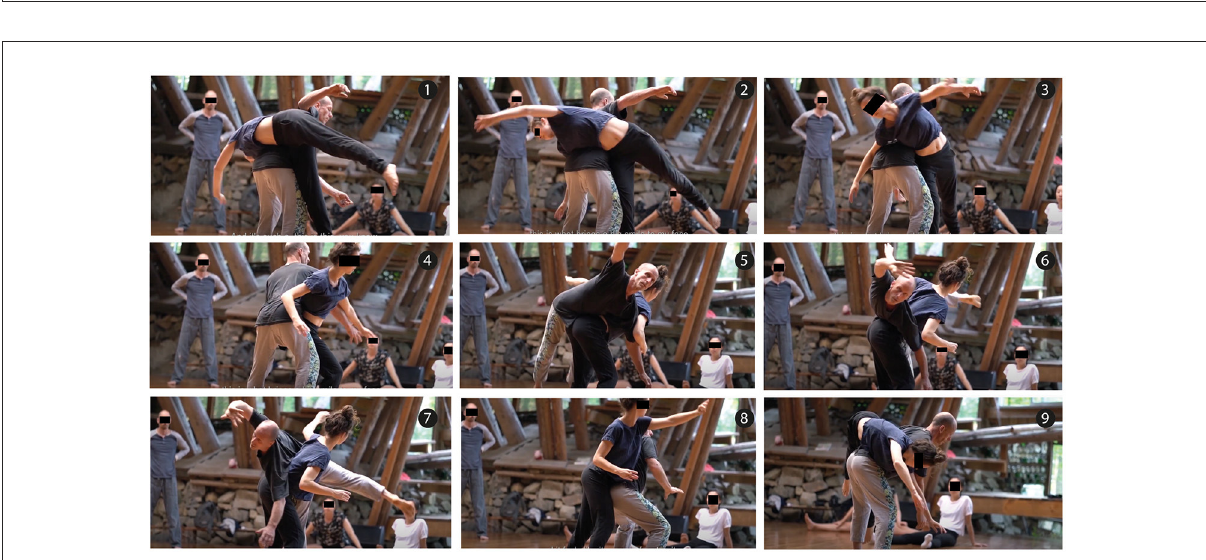
FIGURE4 Contact Improvisation: Technique for maintaining communication through the spiral between dancers in high level. The Choreographer Mark Young demonstrating in pair; Excerpts from the documentary film “Mark Young in Search of Spirality”’ (http://www.flamencoinvestigacion.es/